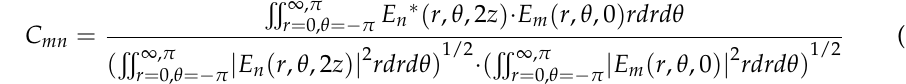
Table 1. Parameters of the models .